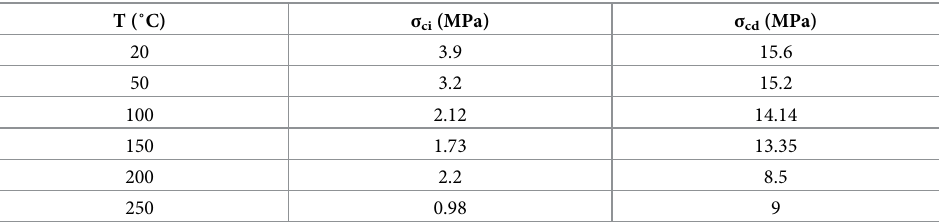
Table 2. The F073 ci and F073 cd values of samples with different